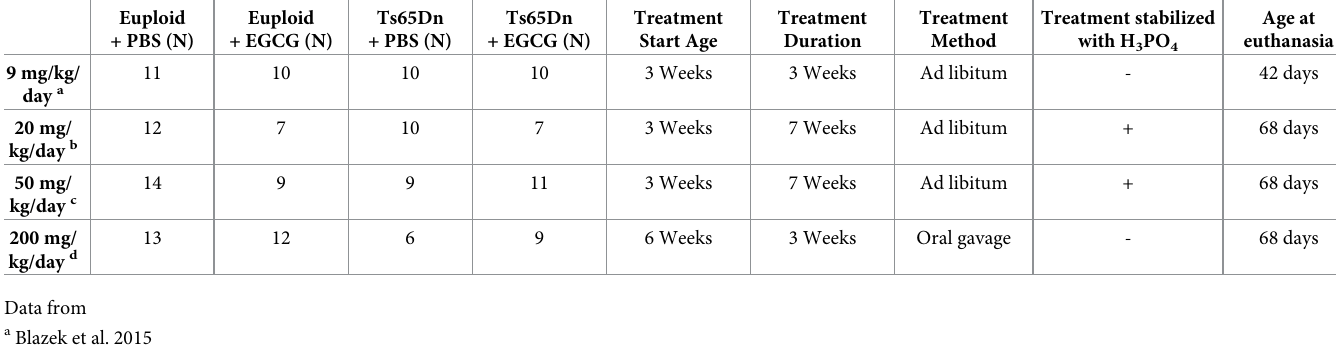
Table 1. EGCG treatment, duration and